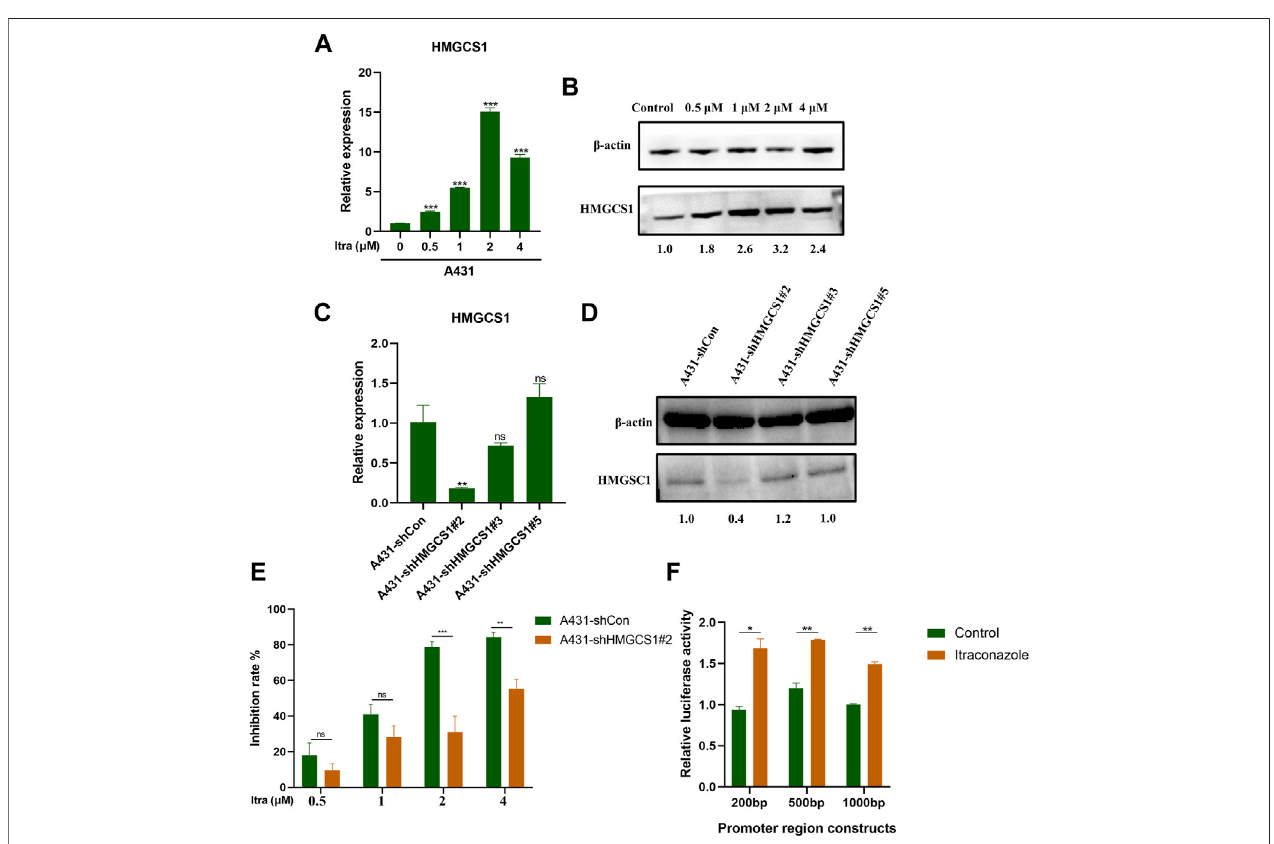
FIGURE 4 | Itraconazole affects human cSCC development by regulating HMGCS1 transcription. (A) The relative mRNAs expression levels of HMGCS1 were presented by qRT-PCR. (B) The relative proteins expression levels of HMGCS1 were presented by western blot. qRT-PCR analysis (C) and western blot (D) were performedtodetectHMGCS1expressioninA431cellsthatweretransfectedwithsh-Con,sh-HMGCS1#2,sh-HMGCS1#3,andsh-HMGCS1#5. (E) A431sh-Conand A431 sh-HMGCS1#2 cells were treated with indicated concentrations of itraconazole for 48 h. Inhibition of cell viability was analyzed by CCK8 assay. (F) The relative luciferase activity was detected by dual-luciferase reporter gene activity assay. [mean ± SD (error bars), n = 3; * p ≤ .05; ** p ≤ .01; *** p ≤ .001, compared with control group].